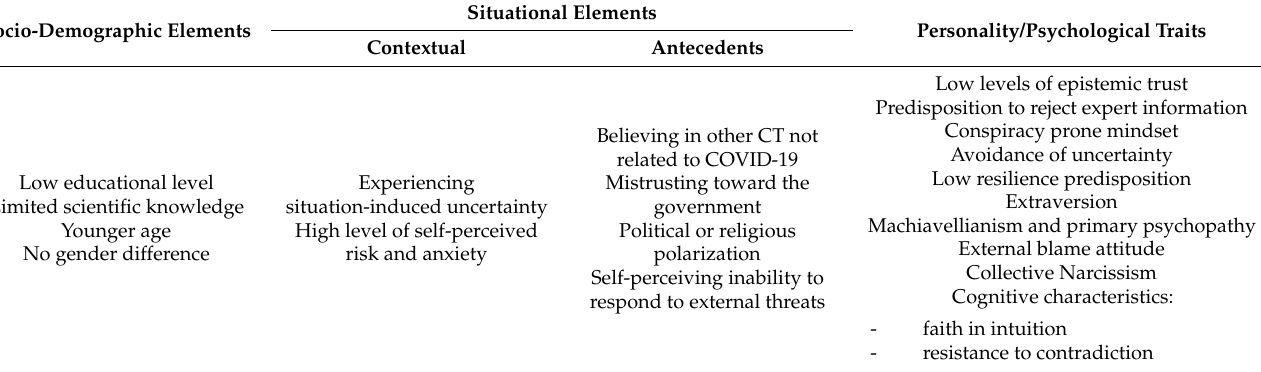
Table 1. Overview of the dispositional and situational explanations of COVID-19 CT endorsement. Socio-Demographic